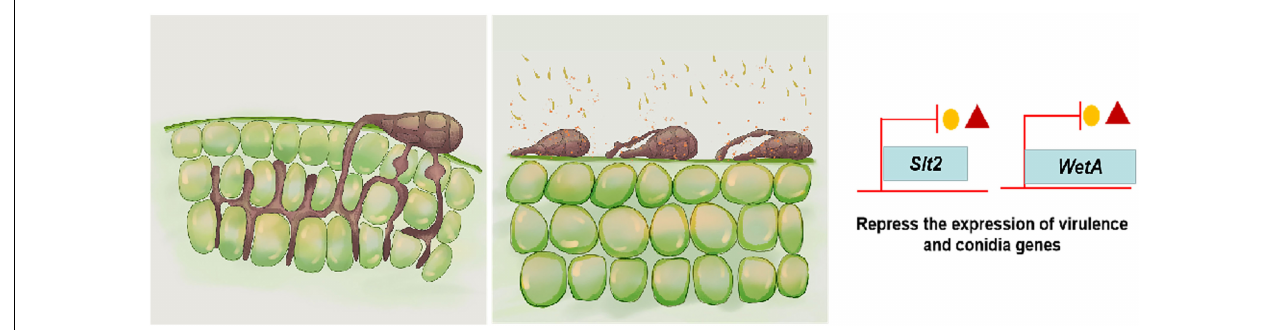
FIGURE 6 | A model for the mode of action of 6-methyl-2-heptanone produced by ZD01 against A. solani . 6-Methyl-2-heptanone changes the structures of mycelia and conidia of A. solani , which subsequently leads to the suppression of fungal growth, mycelium penetration, conidia vitality, and germination, as well as relative virulence and conidia-related gene expression levels. As a result, A. solani failed to infect potato